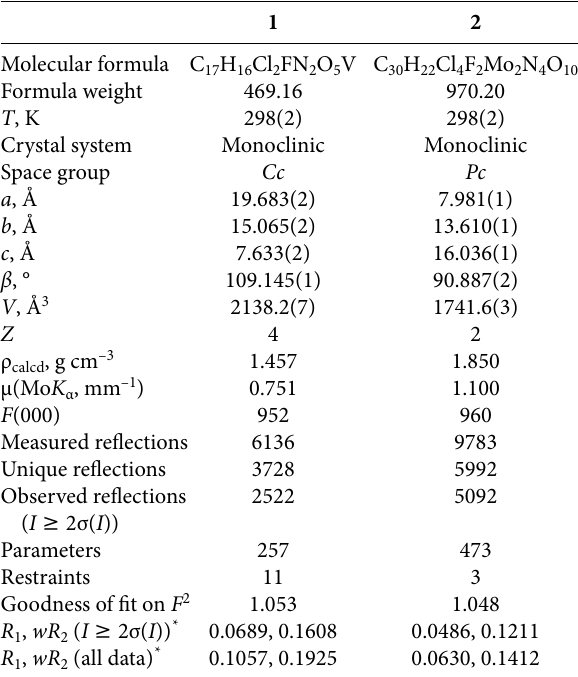
Table 1. Crystallographic and refinement data for the